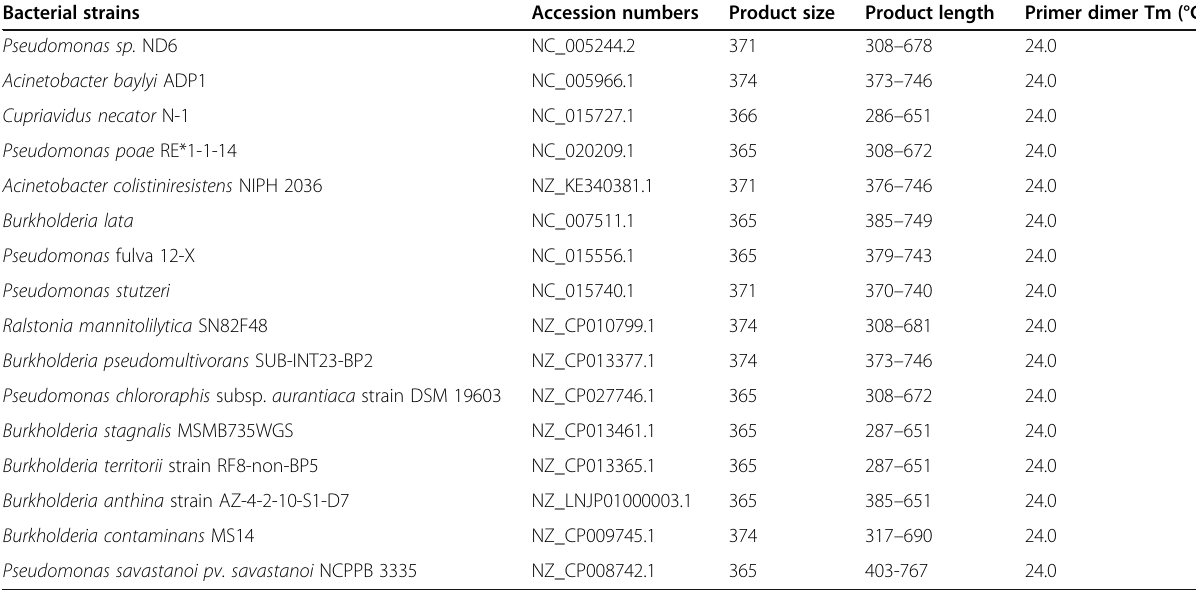
Table 6 In silico PCR analysis of primer pair catAf/catAr with targeted sequences Bacterial strains